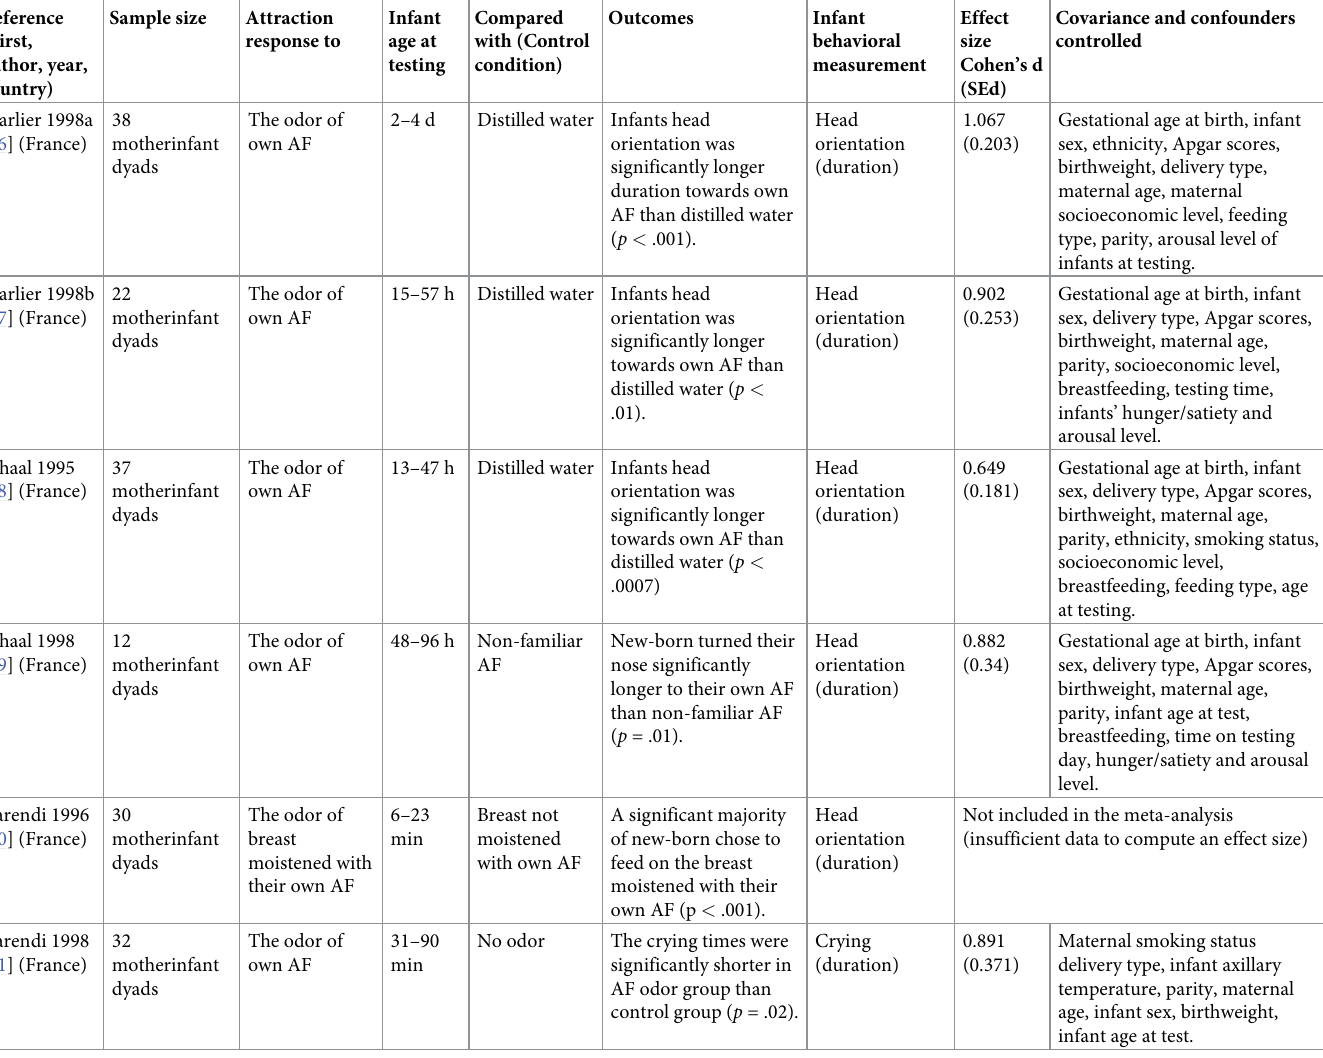
Table 3. Studies that investigated whether infants have different behavioral profiles to the odor of their own amniotic fluid (AF) compared to unfamiliar AF or con- trol (k =